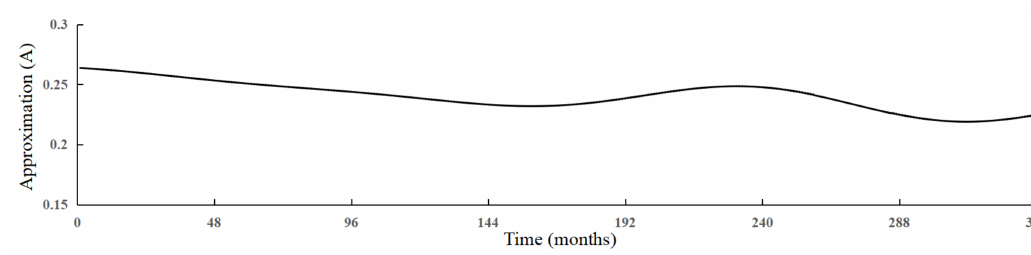
Figure 6. Original sequence of runoff.